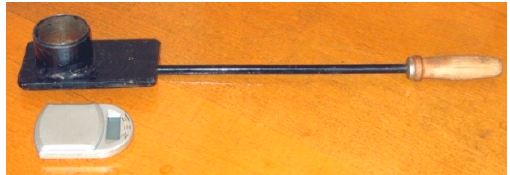
Figure 2. Soil bulk density measuring kit.